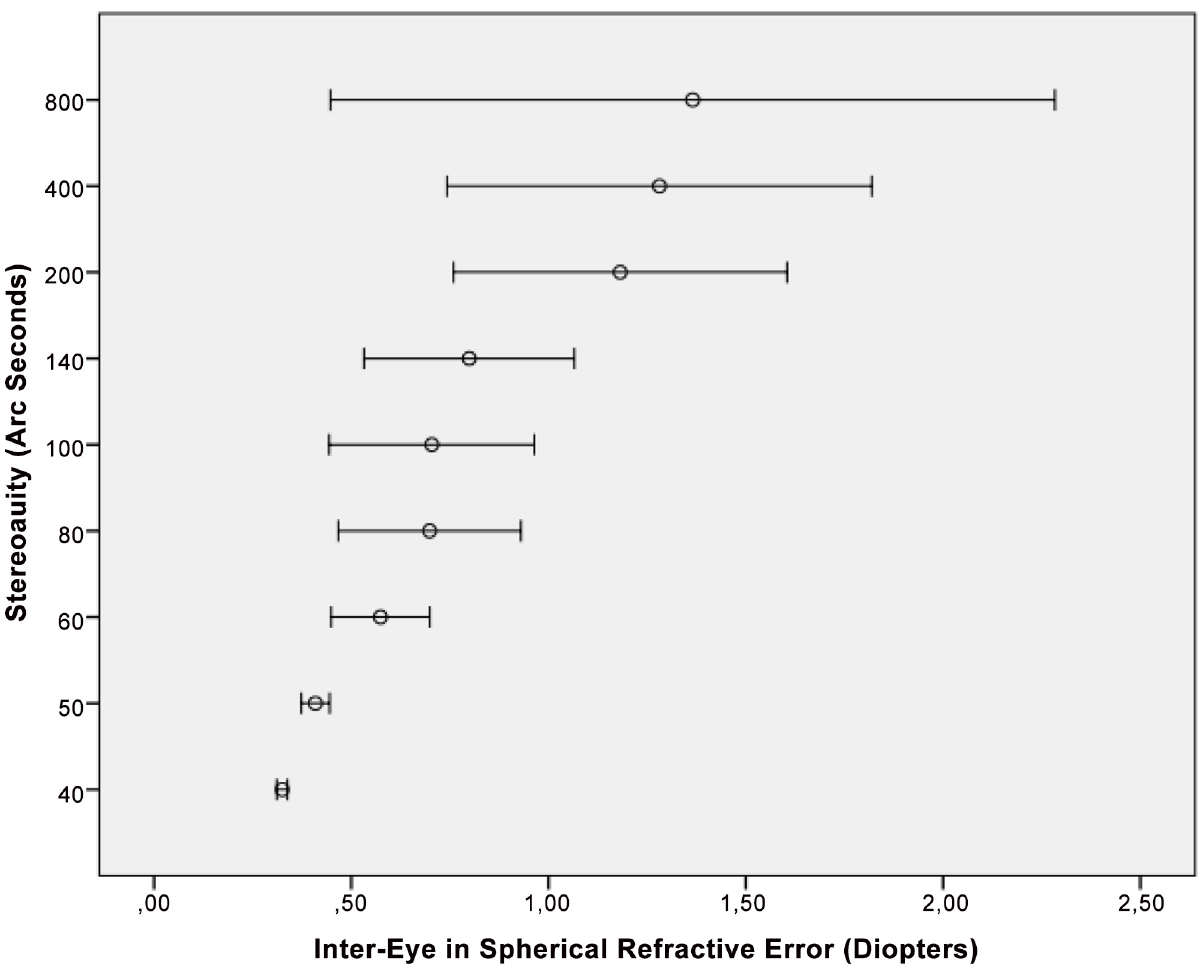
Fig 2. Distribution of Stereoacuity versus the Inter-Eye Difference in Spherical Refractive